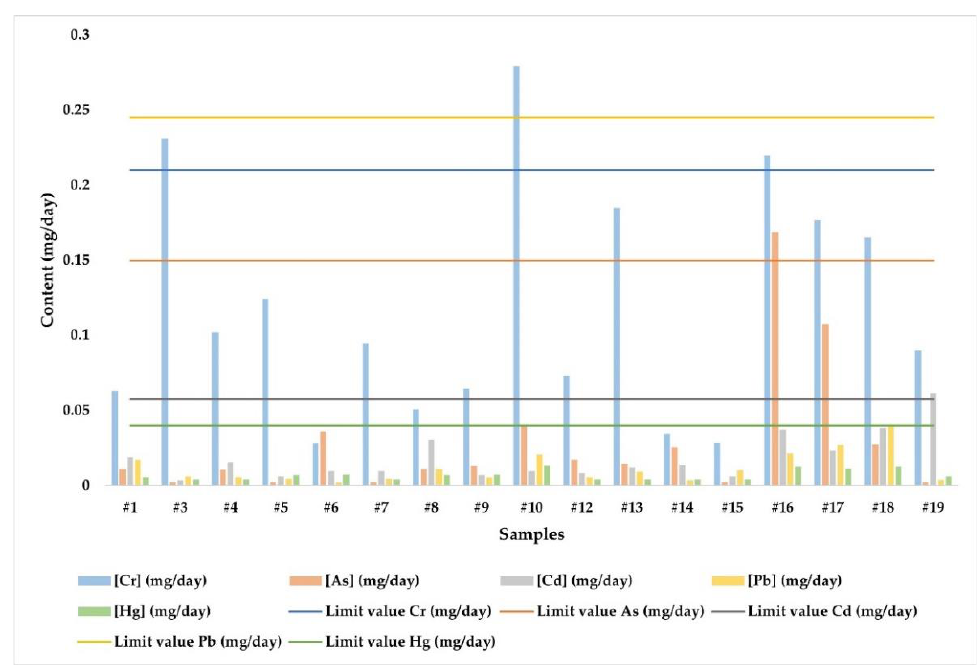
Figure 3. Representation of the toxic metal content of mushrooms of the genus Lactarius and the recommended daily limits.